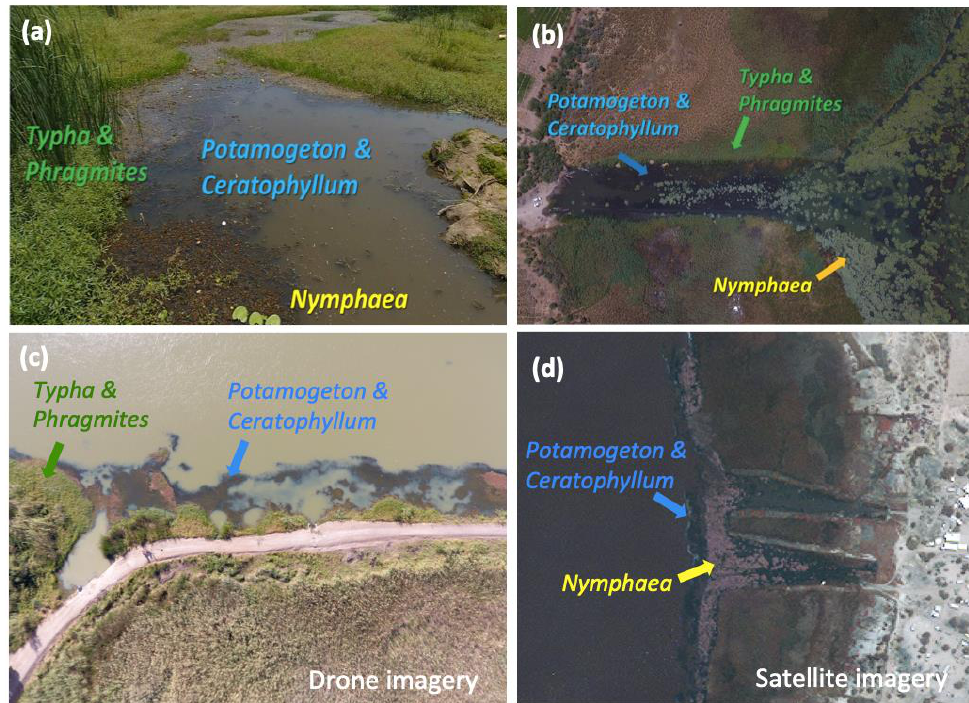
Figure 2. ( a ) Typical vegetation types found at water access points in the SRB, as seen from the shoreline ( b , c ) through drone imagery and ( d ) satellite imagery (WorldView-2). Specific vegetation types are a key indicator of snail presence and abundance and extend far beyond the area safely sampled by trained technicians, thus limiting accurate estimates for human disease risk.